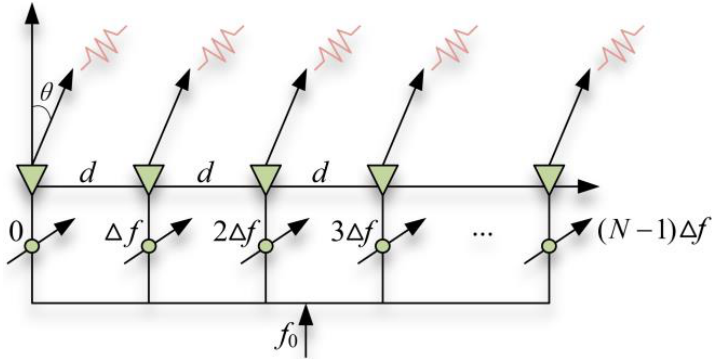
Figure 3. Schematic diagram of the FDA transmitter. The roundtrip of the SAR signals transmitting through the n -th arrays of the FDA to the SAR receiver can be expressed as